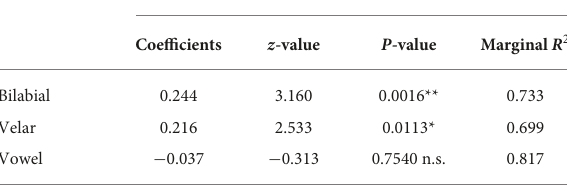
Table 5 for summary